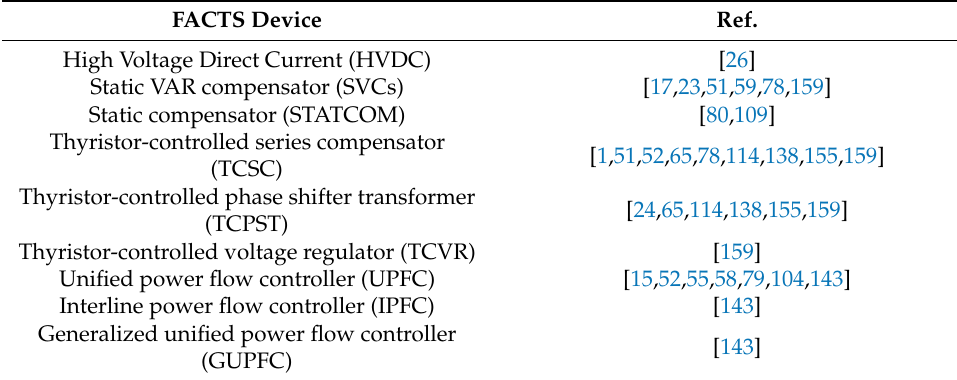
Table 6. Classification of references based on implementing FACTS devices.